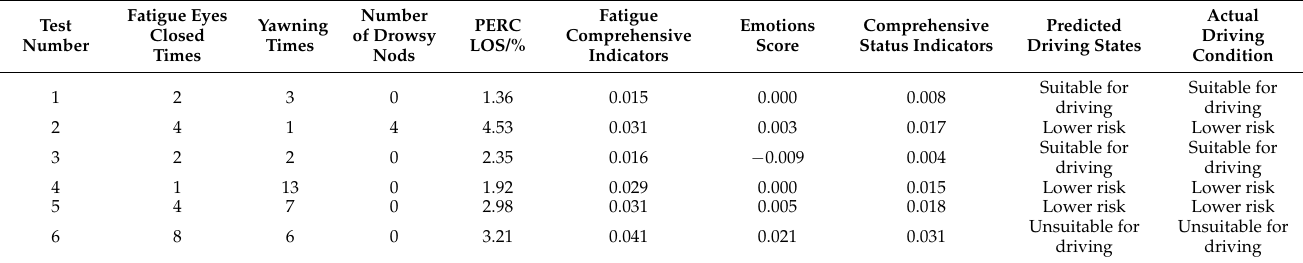
Figure 16. Driver real-time status test interface. Table 8. Driver status classification experimental test.